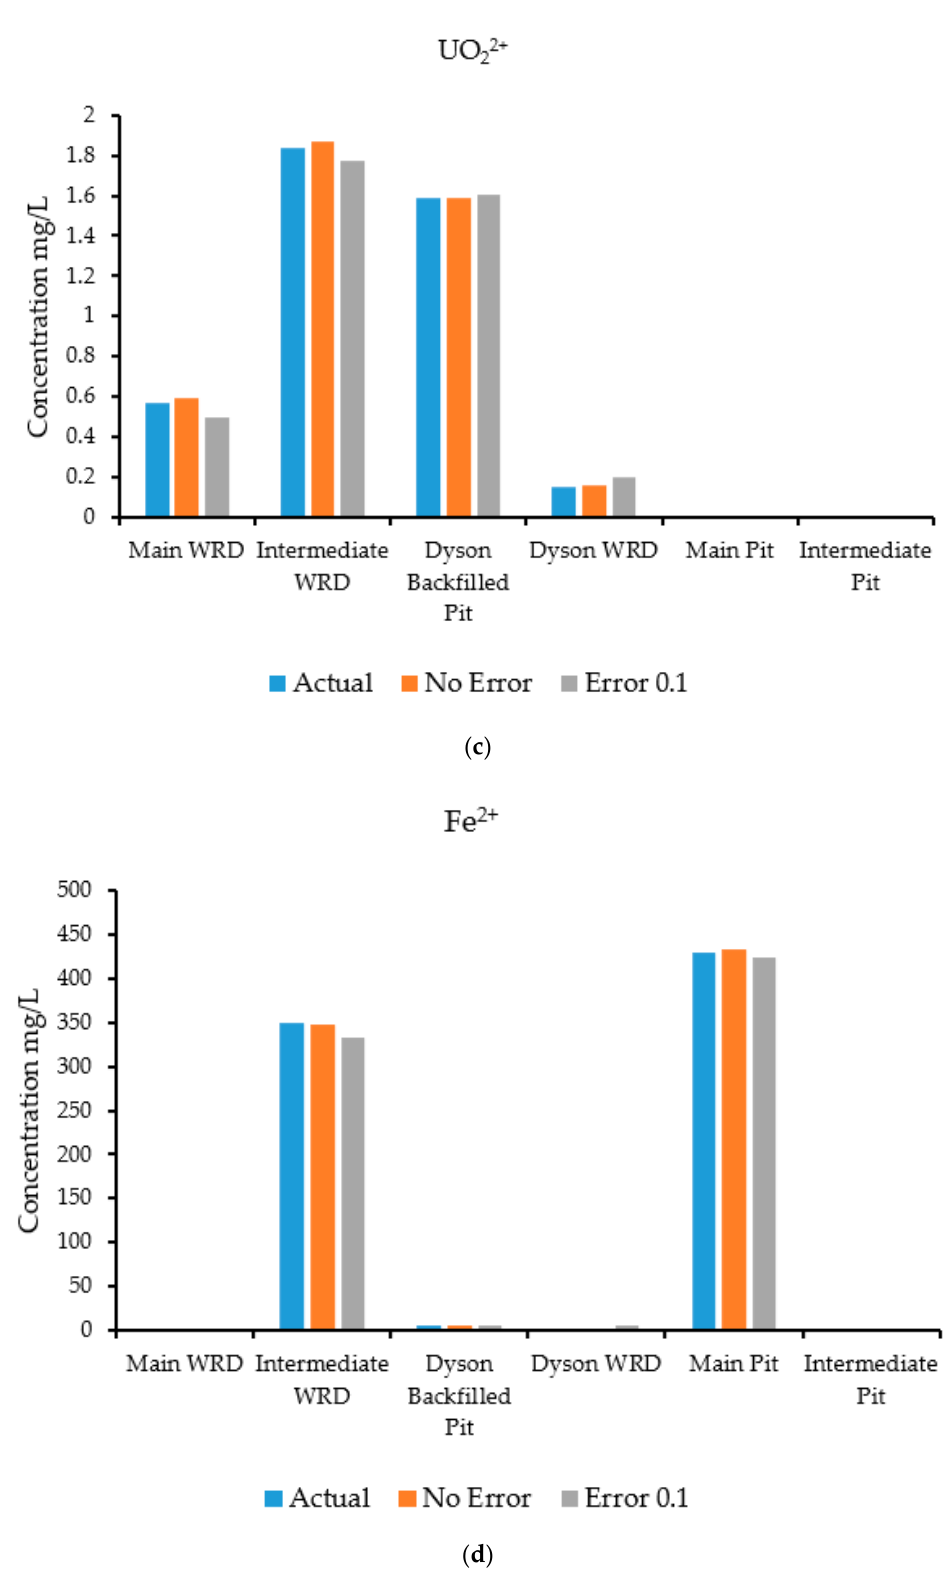
Figure 10. Comparison of species concentrations at sources with a perturbed error of 0.1: ( a ) Cu 2+ species; ( b ) SO 42- species; ( c ) UO 22+ ; ( d ) Fe 2+ species.